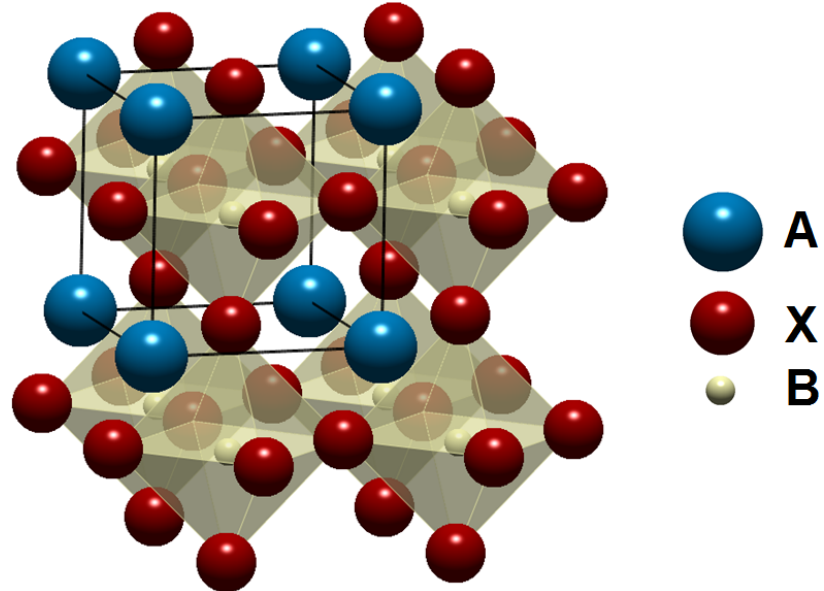
Figure 1. Cubic prototype perovskite structure. Usual cations in lead-free piezoceramics: A = Ba 2+ , Ca 2+ , Bi 3+ , Na + K + ; B = Ti 4+ , Zr 4+ , Nb 5+ ; X = O 2 − .